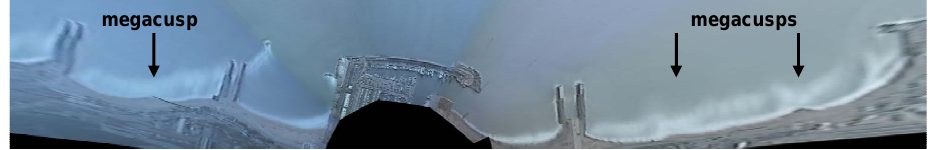
Fig. 5. Plan view image obtained on 8 November 2003 showing the Transverse Bar and Rip state at La Barceloneta with two stable megacusps coupled with the closest sections of the submerged bar. One megacusp is also visible at Bogatell beach.